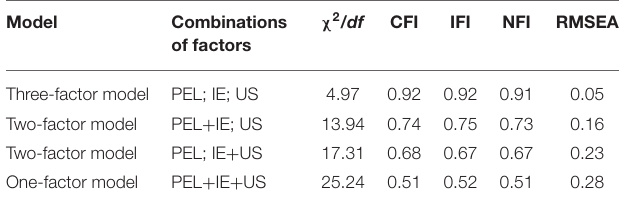
TABLE 2 | Test of structural validity.